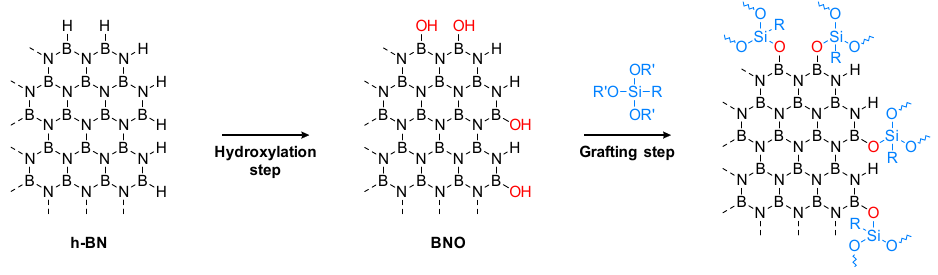
Figure 2. Schematic representation of the h-BN hydroxylation followed by a grafting step.